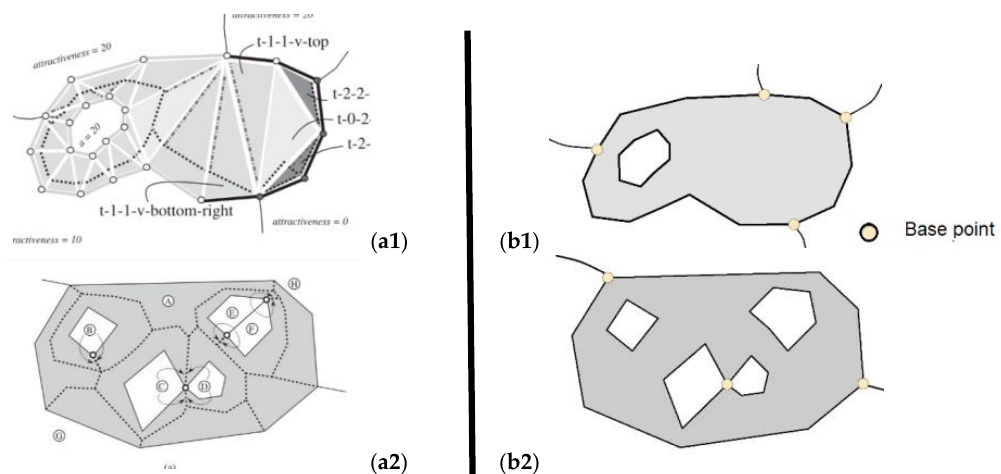
Figure 9. Complex polygons with holes: ( a1 , a2 ) are based on the work of Meijers et al. [10]; ( b1 , b2 ) represent complex polygons with one hole and numerous holes for testing.